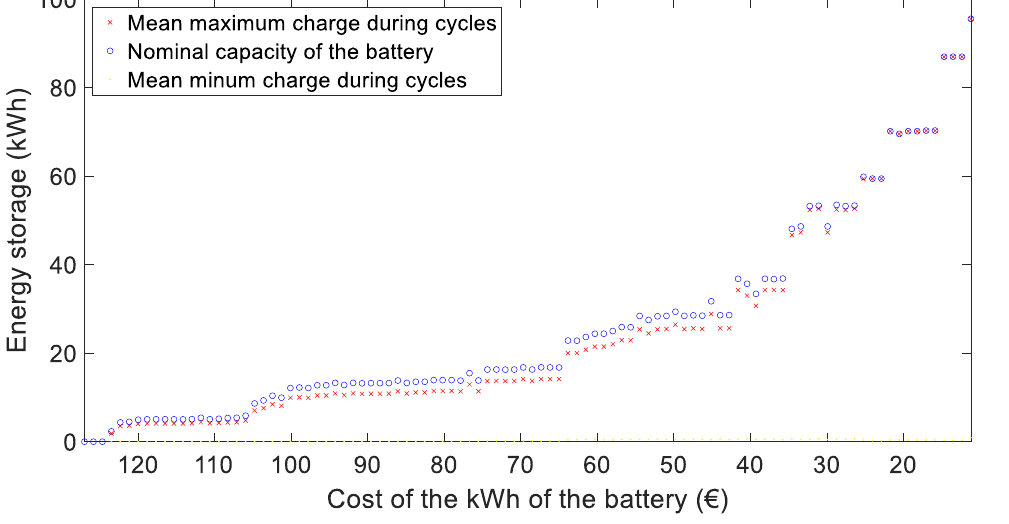
Figure 14. Average maximum and minimum charge (kWh) along the cycles related to the nominal Figure 14. Averagemaximum andminimumcharge(kWh)along thecyclesrelatedtothenominal capacity.